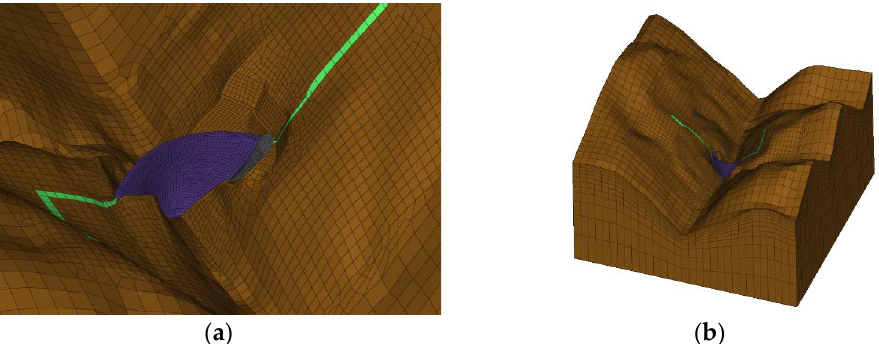
Figure 16. The finite element model of the super-high arch dam. ( a ) The finite element model of the mountain in the vicinity of the dam and the dam body. ( b ) The finite element model of the dam and its